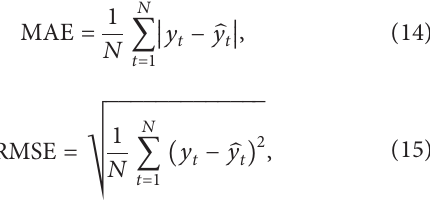
Figure 3: Folded RNN architecture and the process of unfolding with T time steps ( x : input vector; W hidden layers; h : hidden state; W hh : weight matrix between two hidden states; W hy : weight matrix between hidden and output layers; y : output